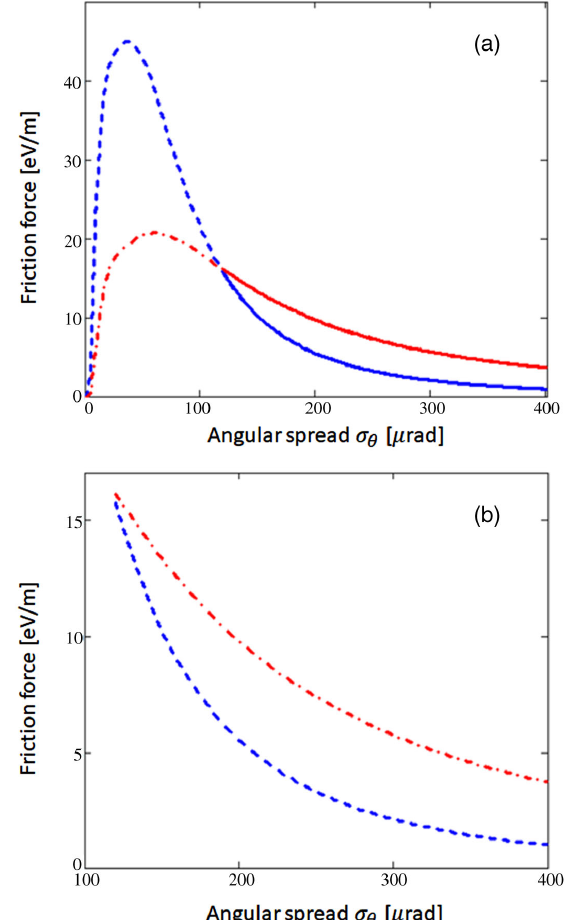
FIG. 4. Transverse (blue dash line) and longitudinal (red dot- dash line) friction force depending on the rms angular spread of the electron bunch. The solid lines in the plot (a) show the friction force for the range of realistically achievable electron angles. The plot (b) is a zoomed-in view of the realistic parameters range. The force is calculated for an ion with v i ¼ parameters from the experiment described in Section IV by integrating Eq. (1) over the electron bunch velocity